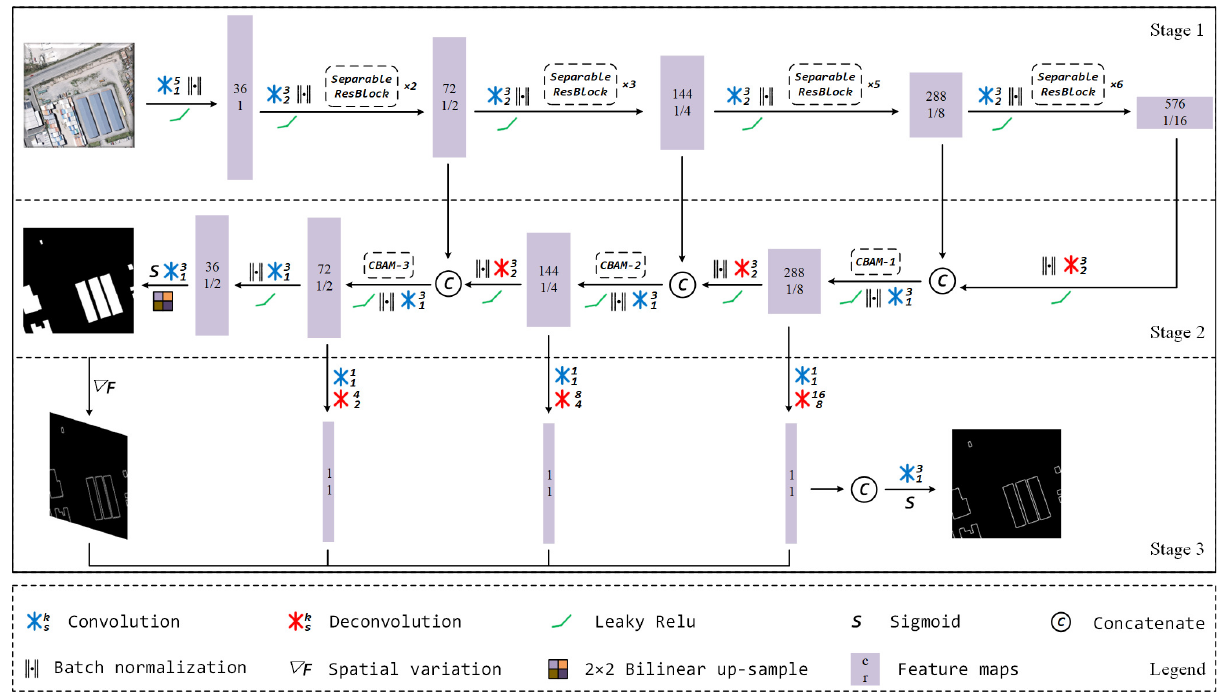
Figure 2. The overall architecture of our framework. The first stage produces multi-level semantics with different spatial resolutions (1/2, 1/4, and 1/16 of the input size, respectively). The second stage parses them to the segmentation mask. The last stage generates the boundary mask. While testing, only the former two stages are